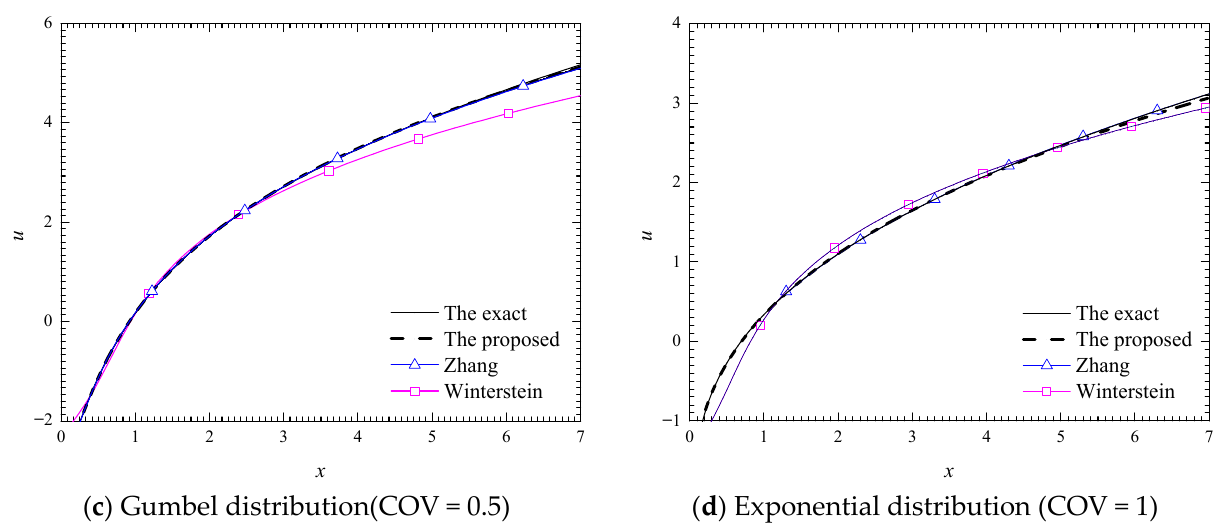
Figure 3. Comparison of x - u transformation with different normal transformation methods.